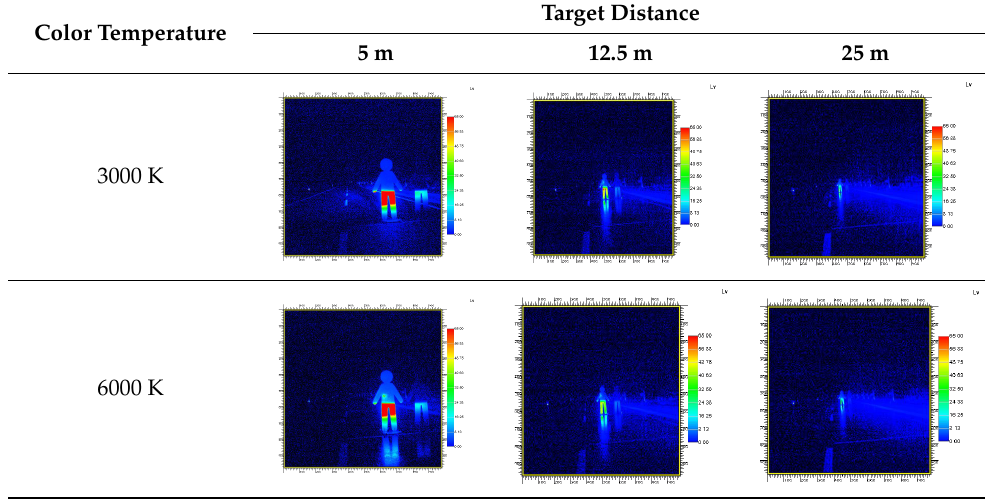
Table 11. Comparison of luminance by target distance and color temperature (rain 20 mm/h).